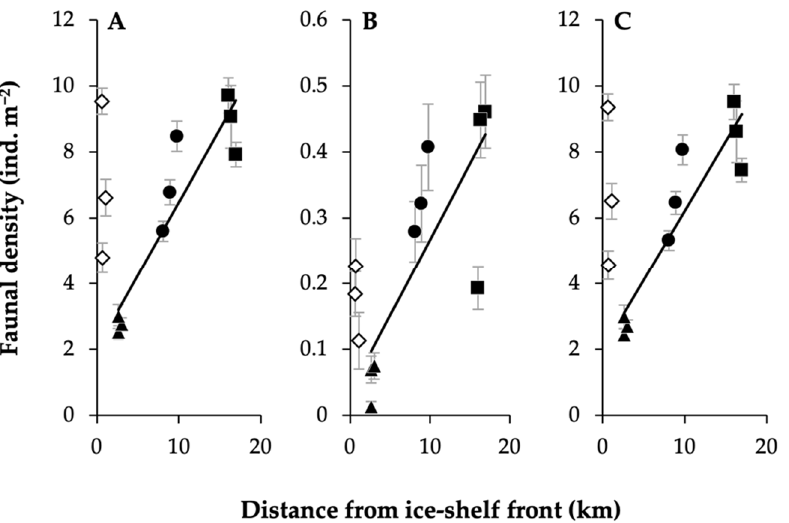
Figure 6. Deposit-feeding crawlers as an effective surrogate of the overall faunal density trend ob- served with distance from the ice shelf. Mean densities (ind. m −2 ) (±SE) with distance from the ice- shelf front (km) of: ( A ) overall fauna; ( B ) deposit-feeding crawlers; and ( C ) overall fauna excluding deposit-feeding crawlers. Site LCP1 = diamonds, LCP2 = triangles, LCP3 = circles, and LCP4 = squares; white-filled symbols indicate data not included in trend-line generation (because of water mass differences, see [90]). R 2 values for A–C = 0.86, 0.63 and 0.85, respectively. Regression statistics for C presented a p -value of